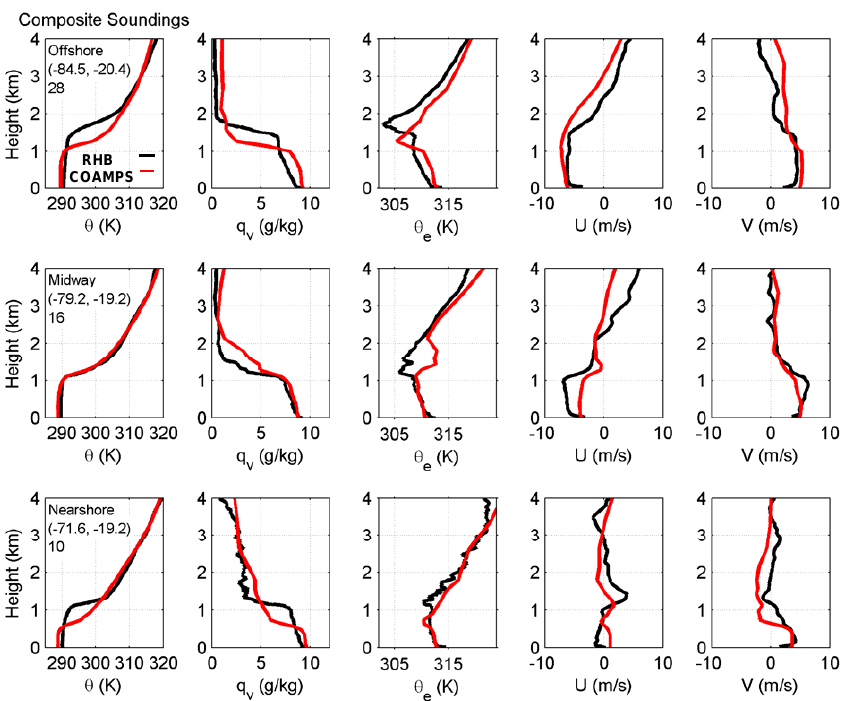
Fig. 7. Comparison of the composite COAMPS and RHB soundings. The soundings are averaged at the central location indicated by the pair of longitude and latitude in the first columns in the figure. The digits under the locations are the total number of soundings used in each averaging. The variables are denoted by x -axis labels. Red curves denote the forecast results; and the black the RHB.